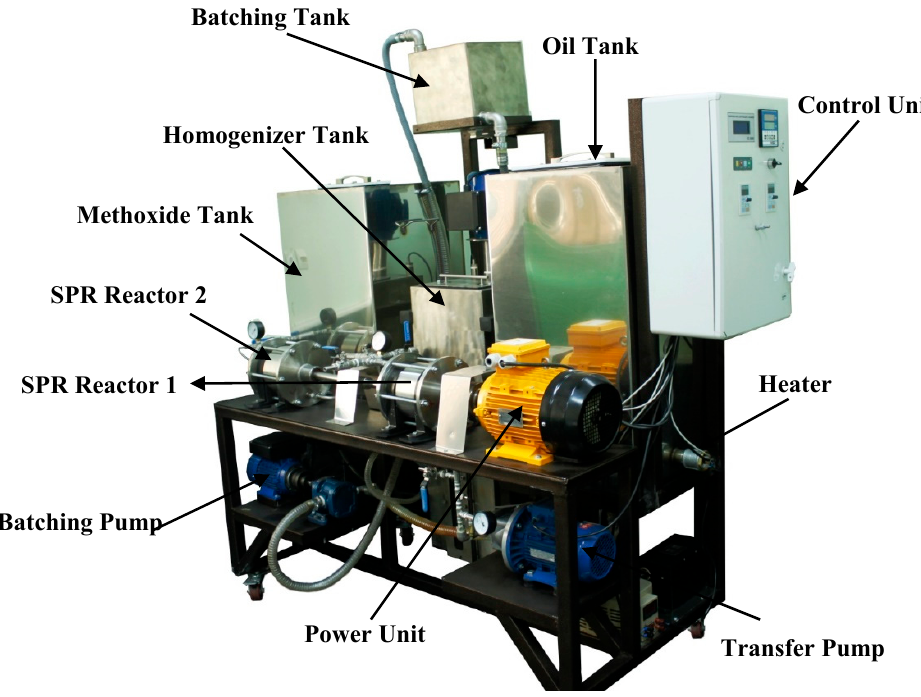
Figure 3. General view of pilot-scale unit.